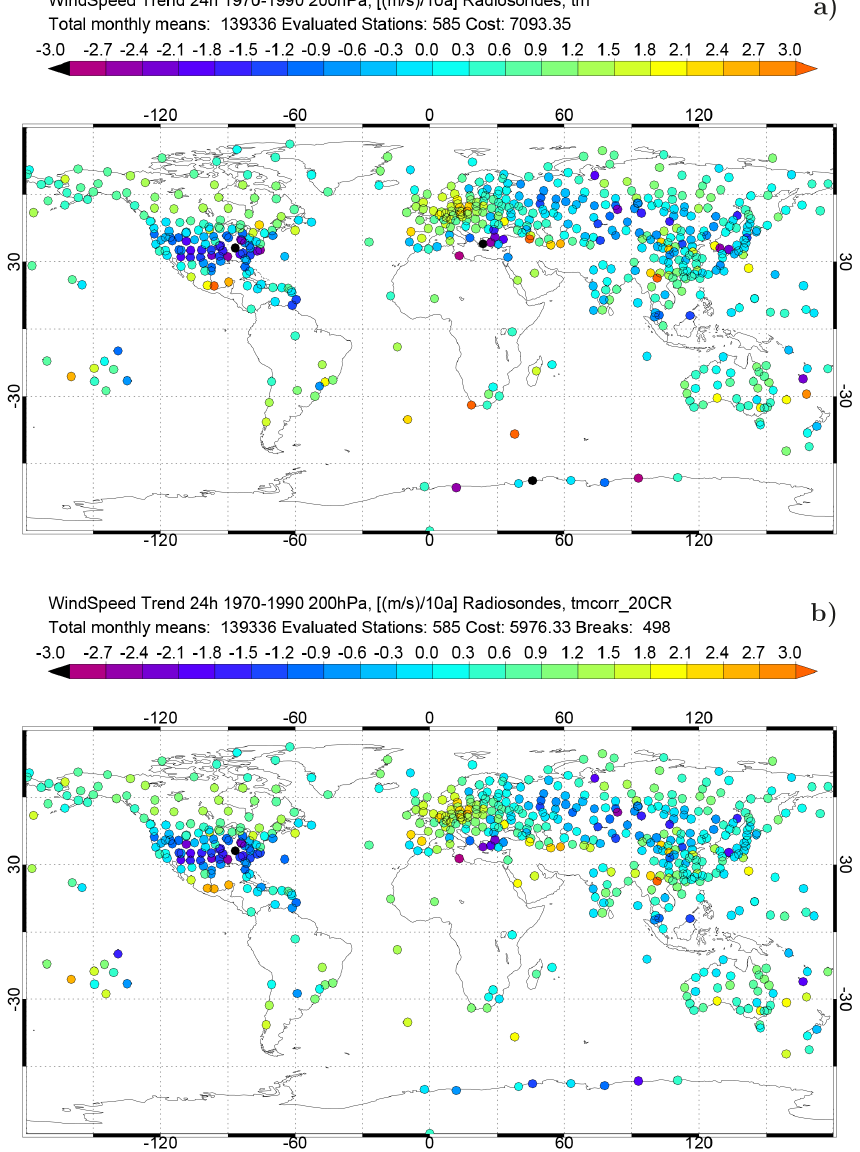
Figure 15. Global observed wind speed trends at 200hPa for the period 1970–1990, (a) before adjustment, (b) after adjustment with RAOBCORE. 585 WMO stations with less than three missing years in the inquired period have been used. Cost values in legend indicate moderate reduction of trend